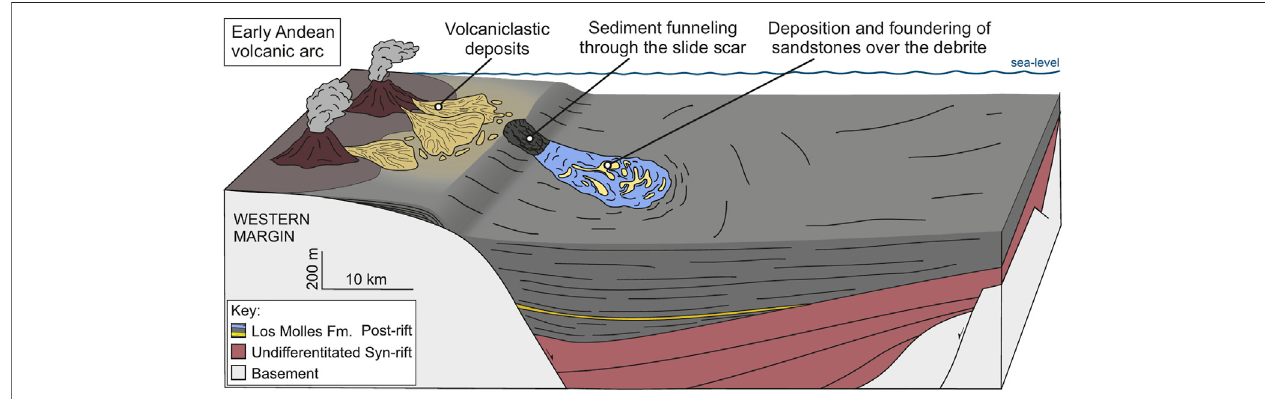
FIGURE 11 | Schematic diagram illustrating the role of the mass failure recorded in the Chacay Melehue depocenter as the trigger for downslope remobilisation of sand from shallow-marine settings.